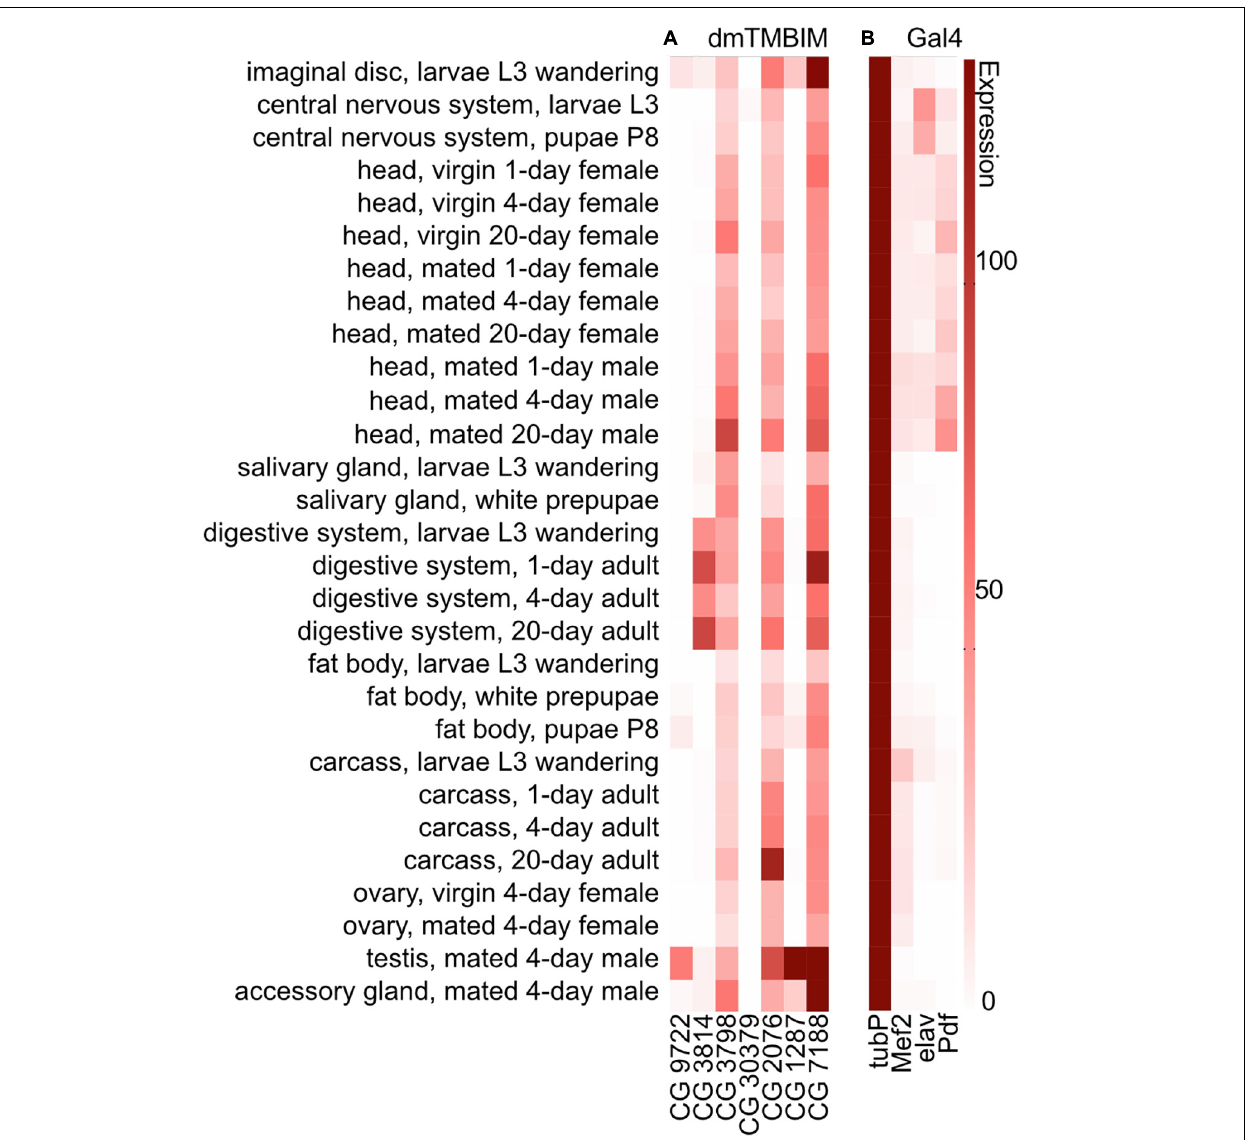
FIGURE 2 | Expression of mRNAs encoding fly TMBIM proteins and Gal4 drivers used in this study. (A) The expression of mRNAs of fly TMBIM proteins (dmTMBIM): CG9722, CG3814/Lfg, CG3798/Nmda1, CG30379, CG2076/dTmbim5, CG1287/Mics1, and CG7188/dTmbim6/BI-1. (B) The expression of Gal4 proteins used